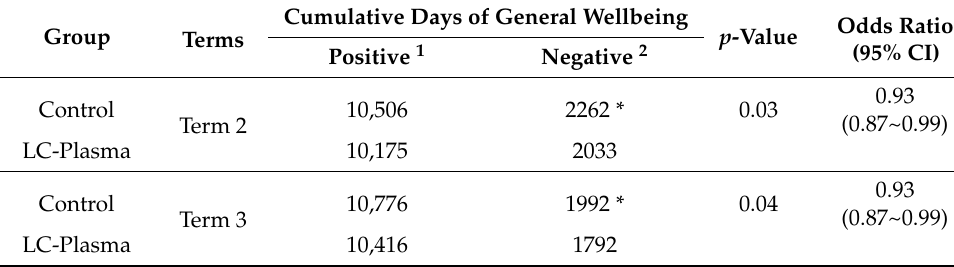
Table 4. Cumulative days with Positive or Negative general wellbeing